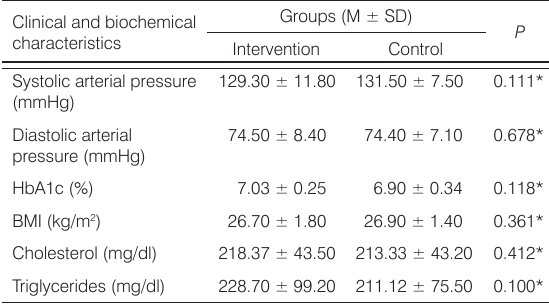
Table 2. Clinical and biochemical characteristics of the participants by groups at the time of inclusion in the study ( n =